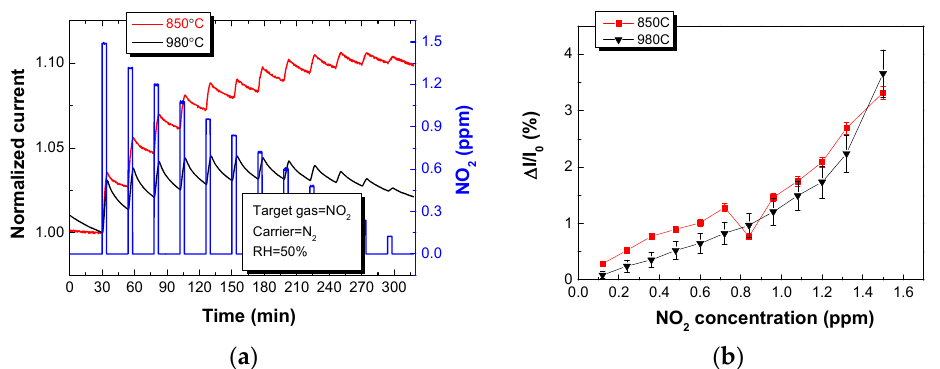
Figure 4. ( a ) Real-time current behavior of the chemi-resistors upon exposure to 12 sequential pulses of NO 2 at different concentrations ranging from 1.5 down to 0.12 ppm. The signals are normalized at I 0 , representing the current value at the gas inlet during the first pulse; ( b ) Plots of Δ I / I 0 as function of NO 2 concentration, where I 0 represents the current value at the gas inlet for each gas